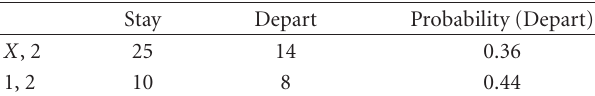
Table 4: Departure patterns of bumble bees on treated inflo- rescences of Aconitum columbianum . Second replication of two microliters of 30% sucrose solution placed in bottom flowers of the inflorescence, zero in second-from-bottom flowers. χ 2 = 3 . 95, P < . 05 . Table 5: Departure patterns of bumble bees on treated inflores- cences of Aconitum columbianum . One microliter of 30% sucrose solution placed in bottom flowers of the inflorescence, zero in second-from-bottom flowers. χ 2 = 0 . 269, P > . 5. Table 6: Departure patterns of bumble bees on treated inflo- rescences of Aconitum columbianum . Second replication of one microliter of 30% sucrose solution placed in bottom flowers of the inflorescence, zero in second-from-bottom flowers. χ 2 = 3 . 72, P < . 06. Table 7: Departure patterns of bumble bees on treated inflores- cences of Aconitum columbianum . Control treatment with zero microliters of 30% sucrose solution in bottom flowers of the inflorescence, and zero in second-from-bottom flowers. χ 2 = 1 . 63, P > .